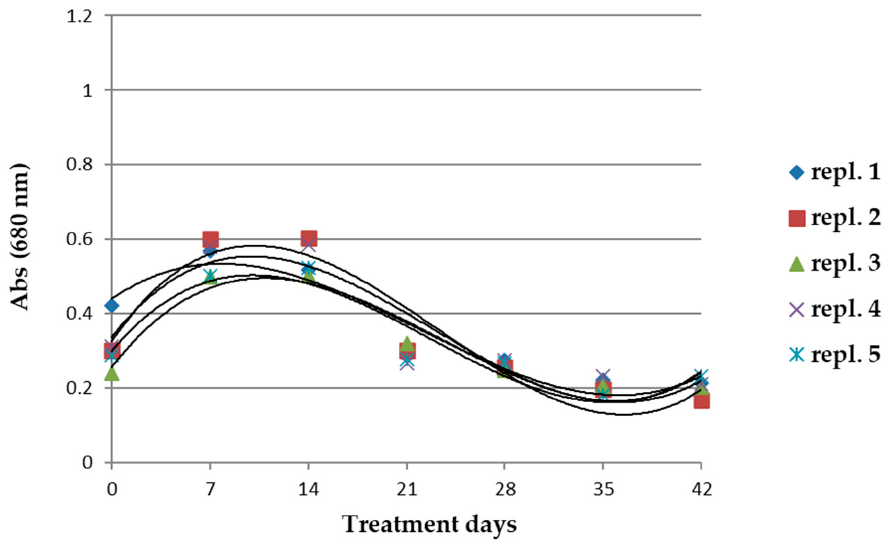
Figure 4. Biomass values evaluated as absorbance of reference samples treated with 0.2 mM glyphosate from cultivations of A. maxima . n = 5. Details of the data are shown in Supplementary Table S1F.